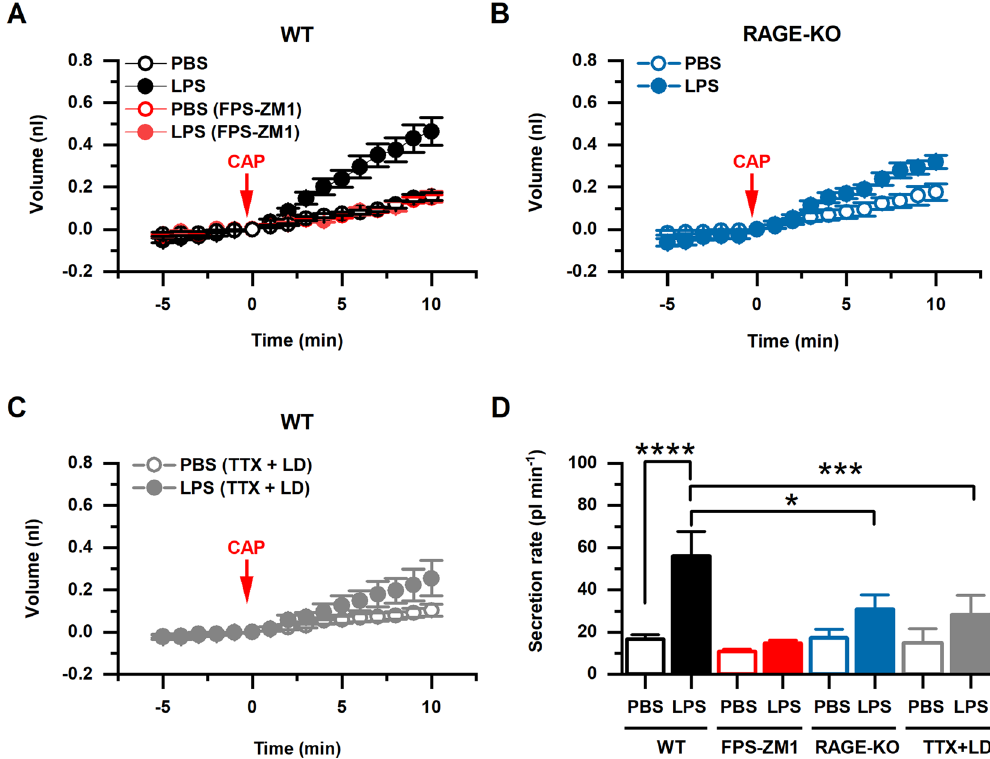
Figure 4. In vivo LPS instillation increased fluid secretion by tracheal submucosal glands, which was prevented by the absence of RAGE or by blocking neuronal activity. ( A ) Capsaicin (CAP) stimulated fluid secretion by tracheas dissected from WT mice treated with PBS (n = 6), LPS (n = 8), PBS (FPS-ZM1) (n = 5), and LPS (LPS-ZM1) (n = 5). ( B ) CAP stimulated fluid secretion by tracheas dissected from RAGE KO mice treated with PBS (n = 5) or LPS (n = 8). ( C ) CAP stimulated fluid secretion by tracheas bathed in vitro with the nervous system blockers TTX and lidocaine (TTX + LD), from animals treated in vivo with PBS (n = 7) or LPS (n = 7). ( D ) CAP stimulated fluid secretion rate (pl/min) in tracheas dissected from WT mice (PBS n = 11, LPS n = 17), WT mice treated with FPS-ZM1 (PBS n = 5, LPS n = 5), RAGE KO mice (PBS n = 5, LPS n = 8), and tracheas (from WT mice) treated in vitro with TTX + LD (PBS n = 7, LPS n = 7). Data presented as mean ± SEM. Means were statistically compared by 2-way ANOVA, followed by Tukey’s multiple comparison test; *, p < 0.05; ***, p < 0.001; **** p <